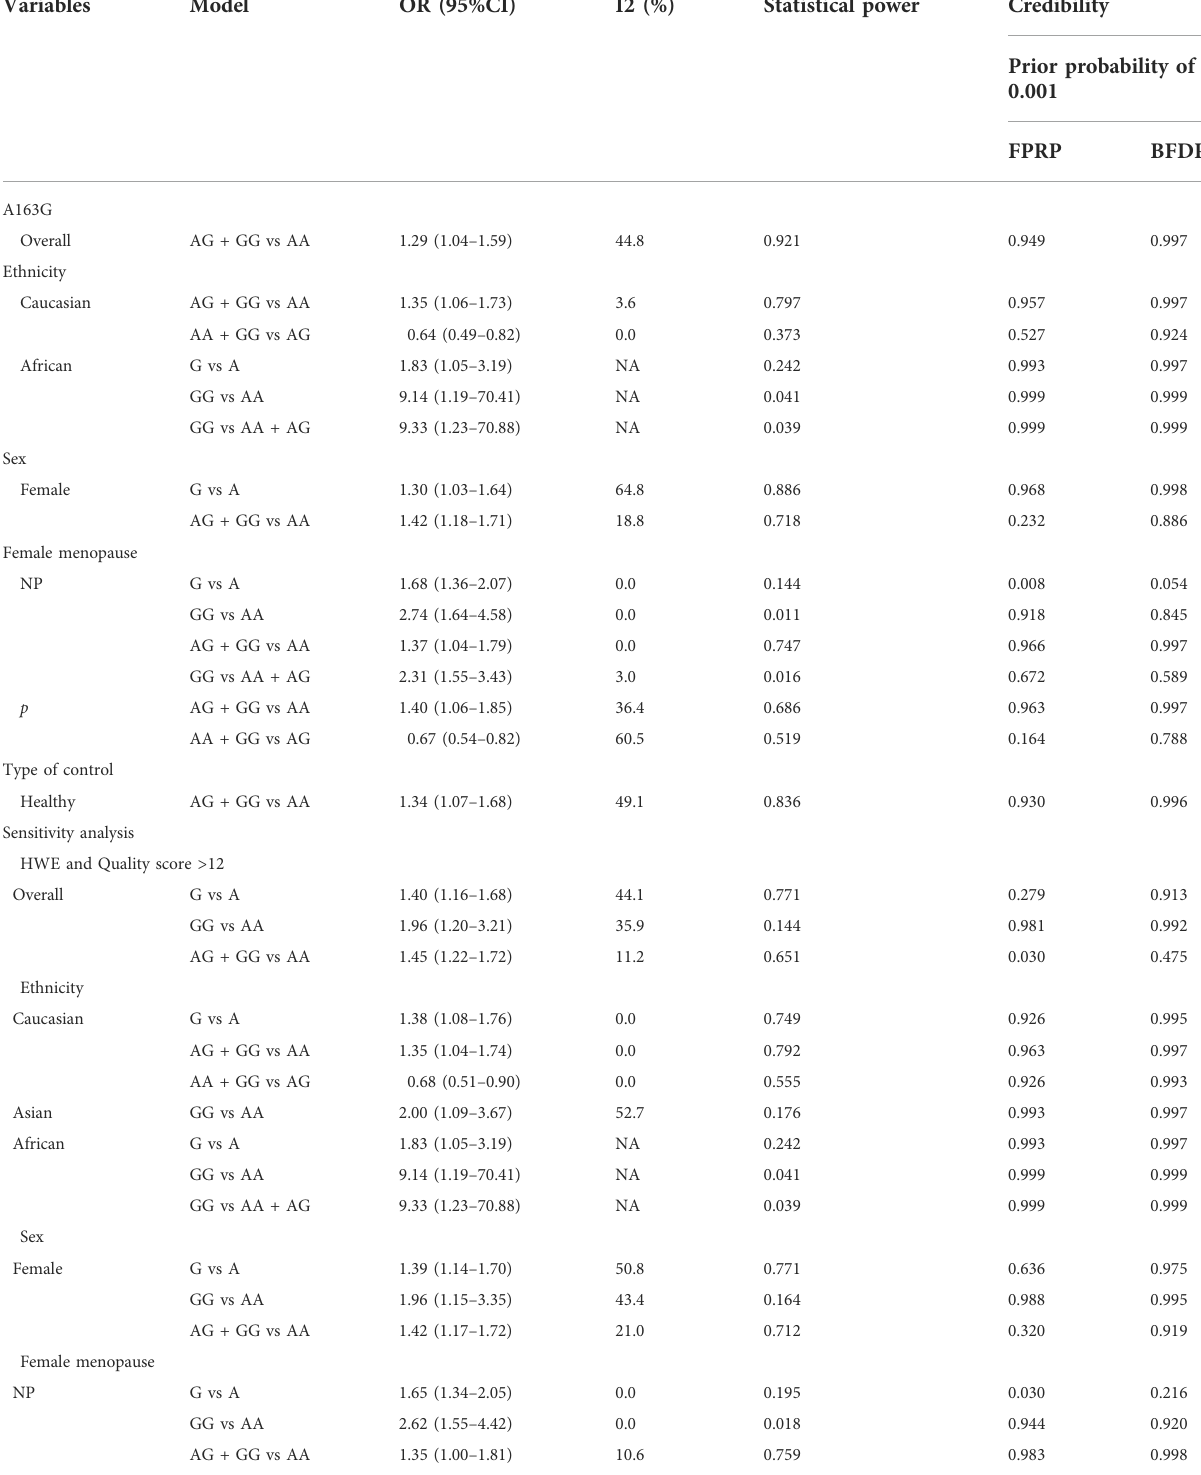
TABLE 6 Credibility of the current